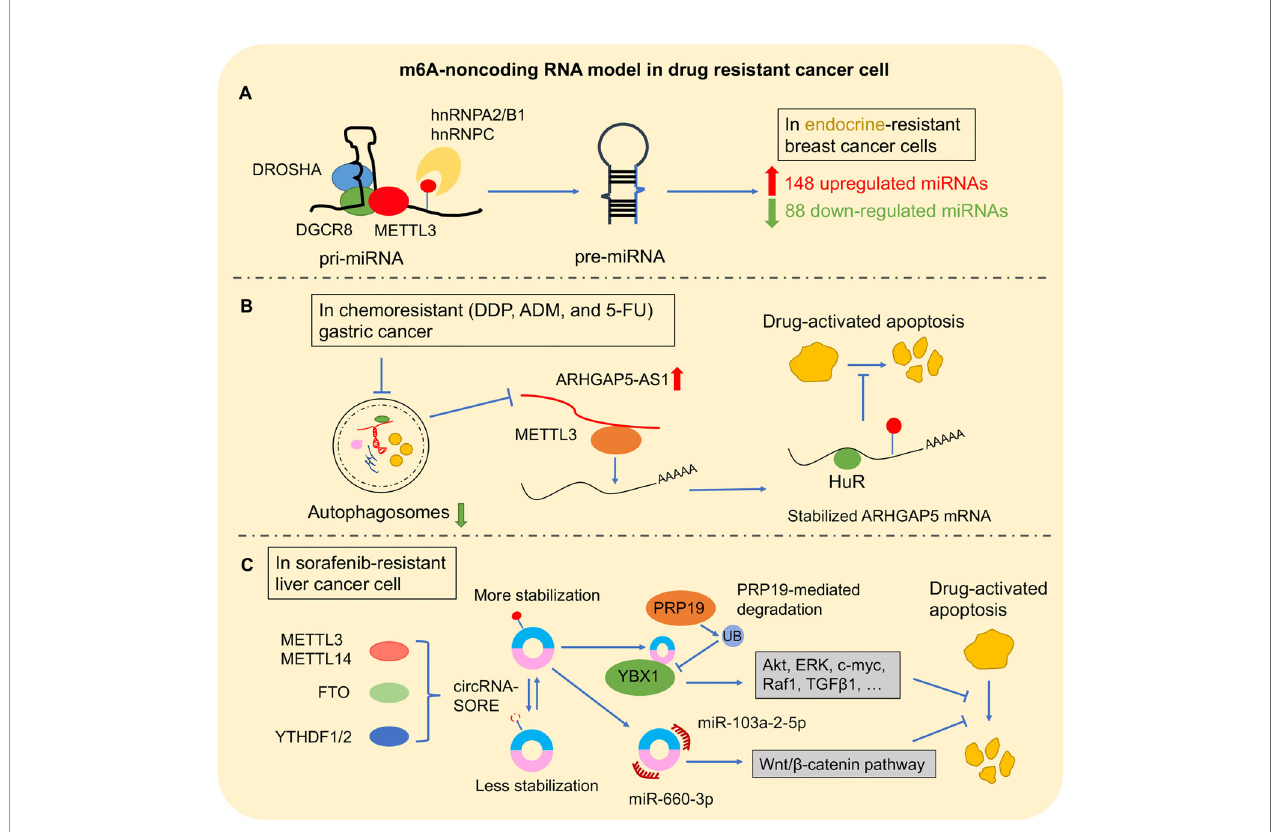
FIGURE 4 | The m6A – non-coding RNA model in drug-resistant cancer. (A) m6A – miRNA model: m6A modi fi cation directly affects the pre-miRNA splicing, resulting in abnormal miRNA level changes in cancer drug resistance. (B) m6A – lncRNA model: ARHGAP5-AS1 recruits METTL3 to promote the stability of ARHGAP5 for inhibiting drug-induced apoptosis. (C) In sorafenib-resistant liver cancer cell, m6A modi fi cation promoted circRNA-SORE stabilization. Then, circRNA-SORE could directly bind YBX1 protein or sponge miR-660-3p and miR-103a-2-5p for arresting drug-activated